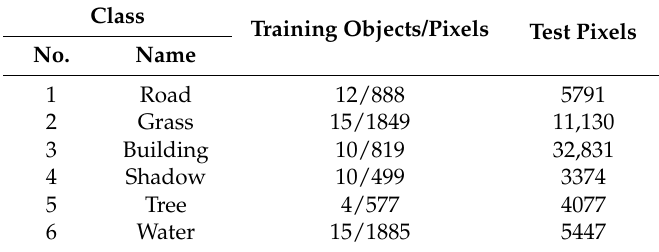
Table 4. Number of training and test data for UAV image-2.